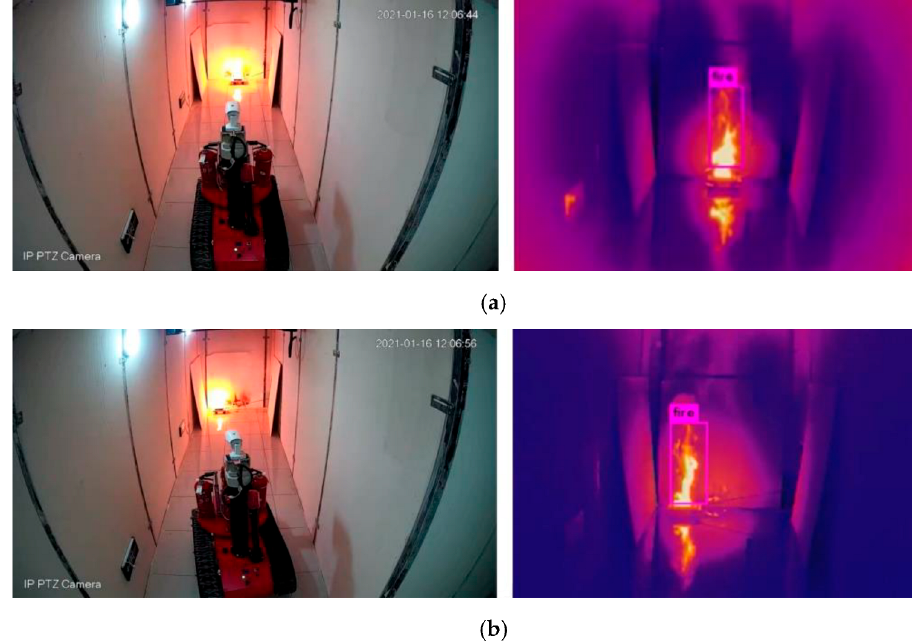
Figure 22. The robot can still aim at the flame after moving the flame: ( a ) The robot is aimed at the flame. ( b ) The mobile flame robot turns to automatically aim at the flame.